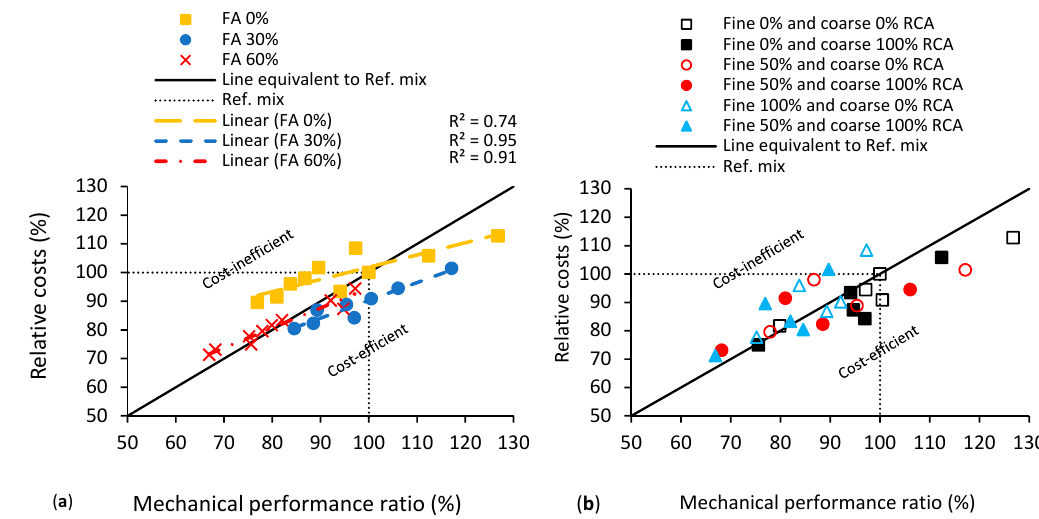
Figure 8. Relationship between relative cost and mechanical performance ratio of concrete mixes made with (square signs) and without (other signs) SP, regardless of the binders and aggregates used. FA, F, C, and SP stand for fly ash, fine RCA, coarse RCA, and superplasticizer, respectively, and the values are their incorporation level in the mixes.